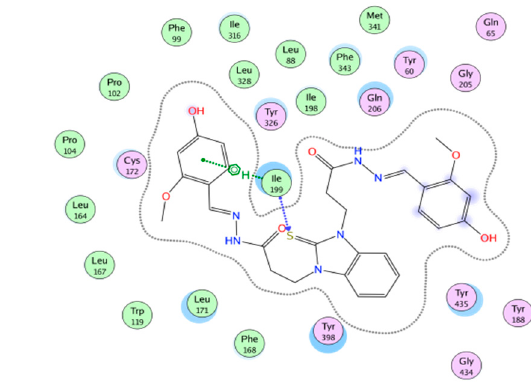
Figure 5. Three-dimensional (3D) representation of the interactions of the ligands in the MAO-B cavity ( left part ) and interaction maps ( right part ); the following colours have been used for representing the different components: the proximity contour—depicted by a black dotted line, polar amino acids—pink, lipophilic amino acids—green, basic amino acids—blue, acidic amino acids—red; hydrogen bond interactions—depicted by blue arrows, lipophilic interactions—green dotted lines. Docked structures are represented by the balls and sticks method, while FAD is represented by sticks.